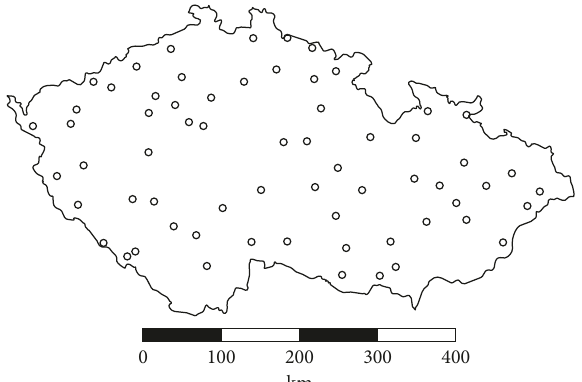
Figure 1: Map of involved weather stations in the Czech